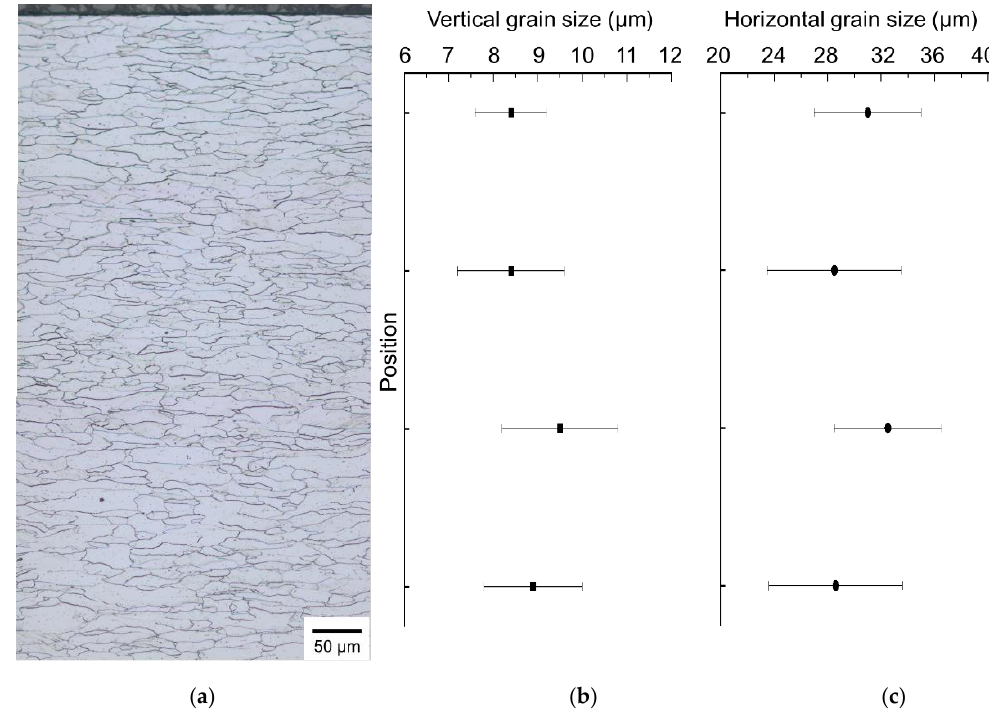
Figure 4. ( a ) Optical microscope images of a cross-section of a DC04 sheet with d s = 1.3 mm as well as corresponding ( b ) vertical and ( c ) horizontal grain sizes across the sheet thickness. Due to symmetry, only one half of the cross-section of the sheet is shown.